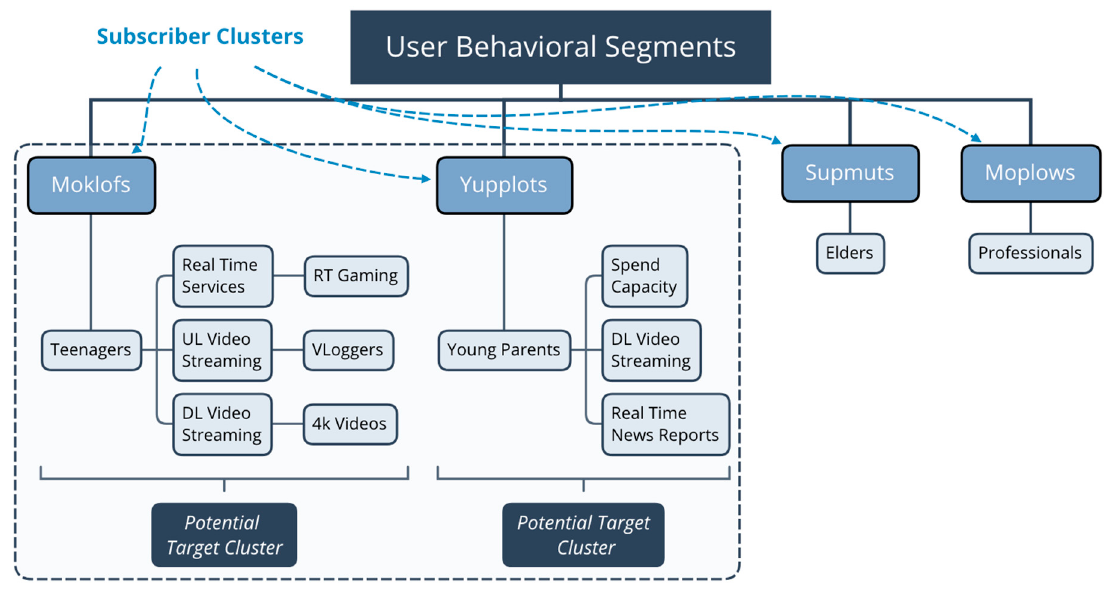
Figure 3. Potential target clusters to focus upon.